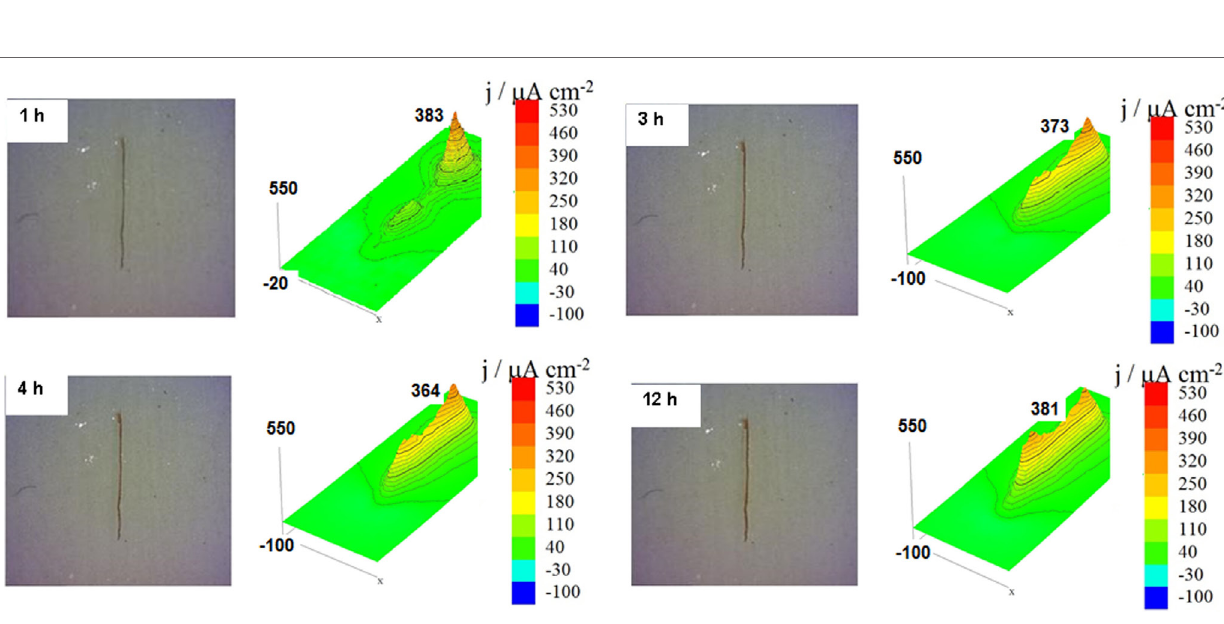
November 2015 | Volume 2 | Article 69